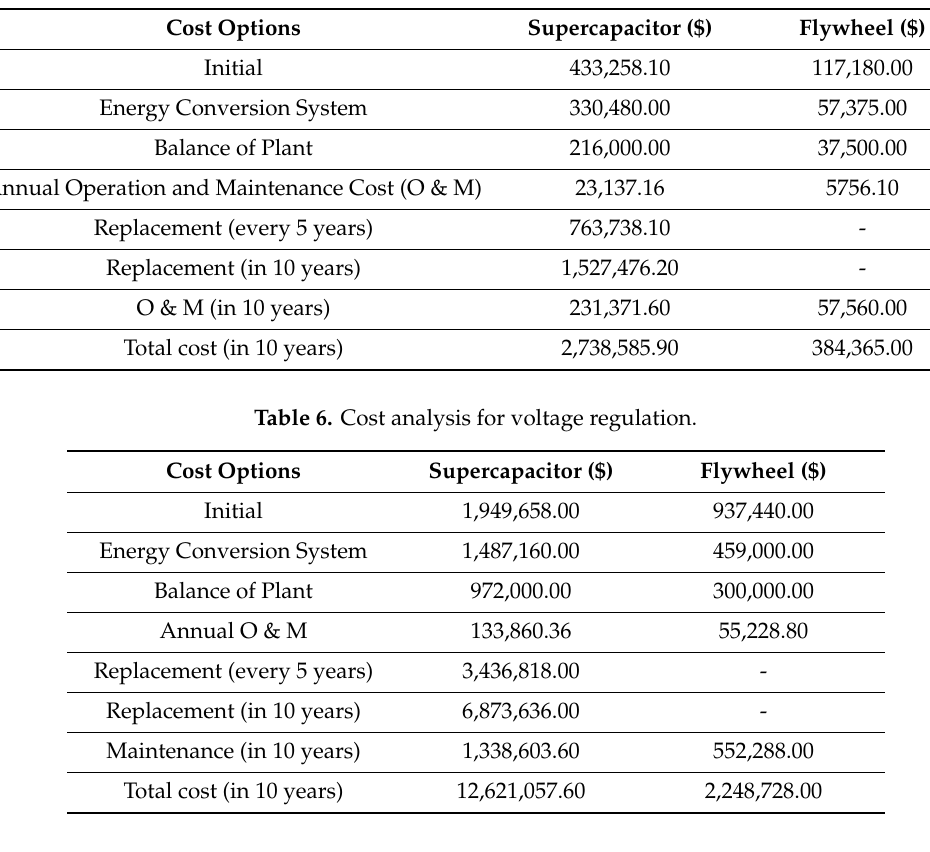
Table 5. Cost analysis for peak demand reduction.